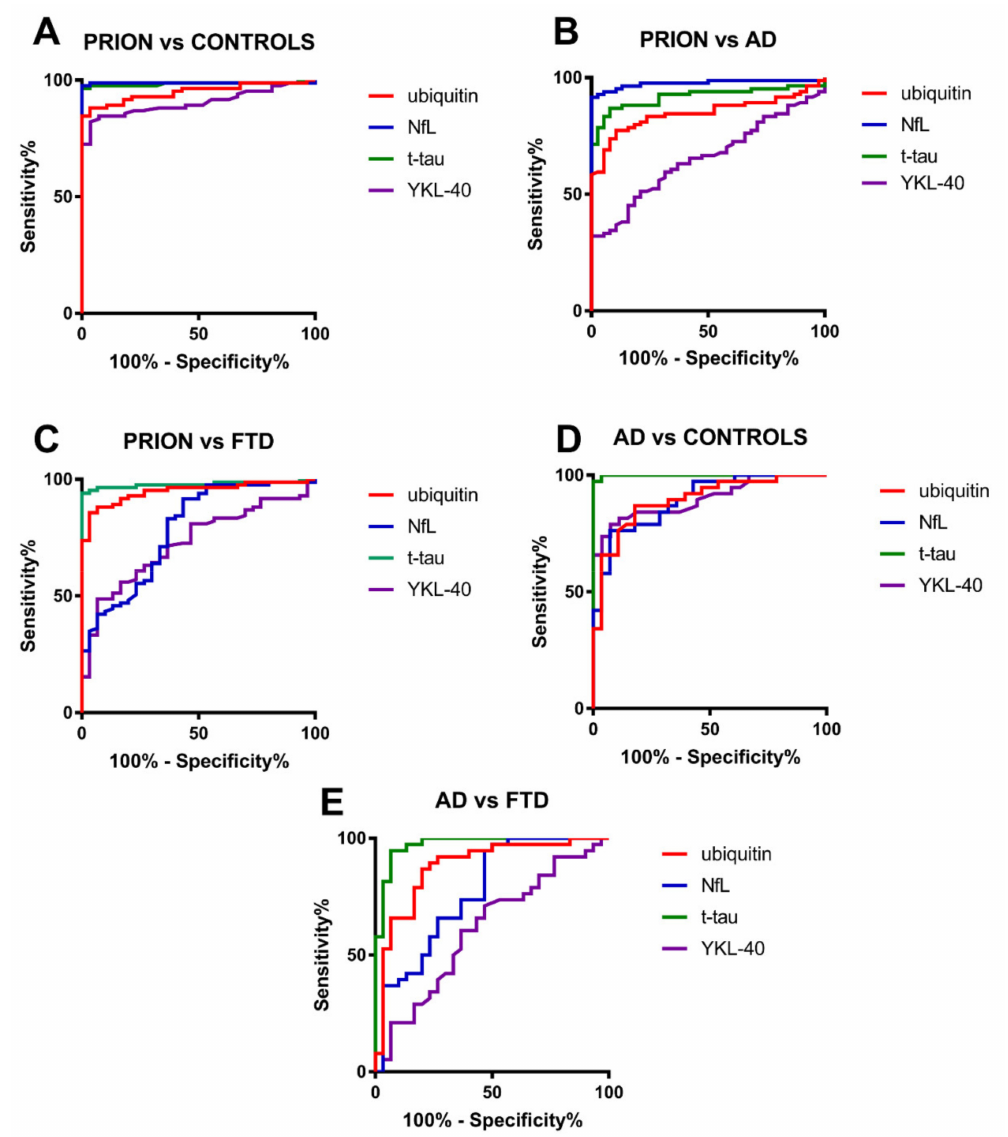
Figure 2. ROC curves of CSF ubiquitin, NfL, t-tau and YKL-40 in the di ff erential diagnosis of neurodegenerative dementias (NDs). ( A ) Comparison between prion disease (PRION) and controls. ( B ) Comparison between PRION and Alzheimer’s disease (AD). ( C ) Comparison between PRION and frontotemporal dementia (FTD). ( D ) Comparison between AD and controls. ( E ) Comparison between AD and FTD.